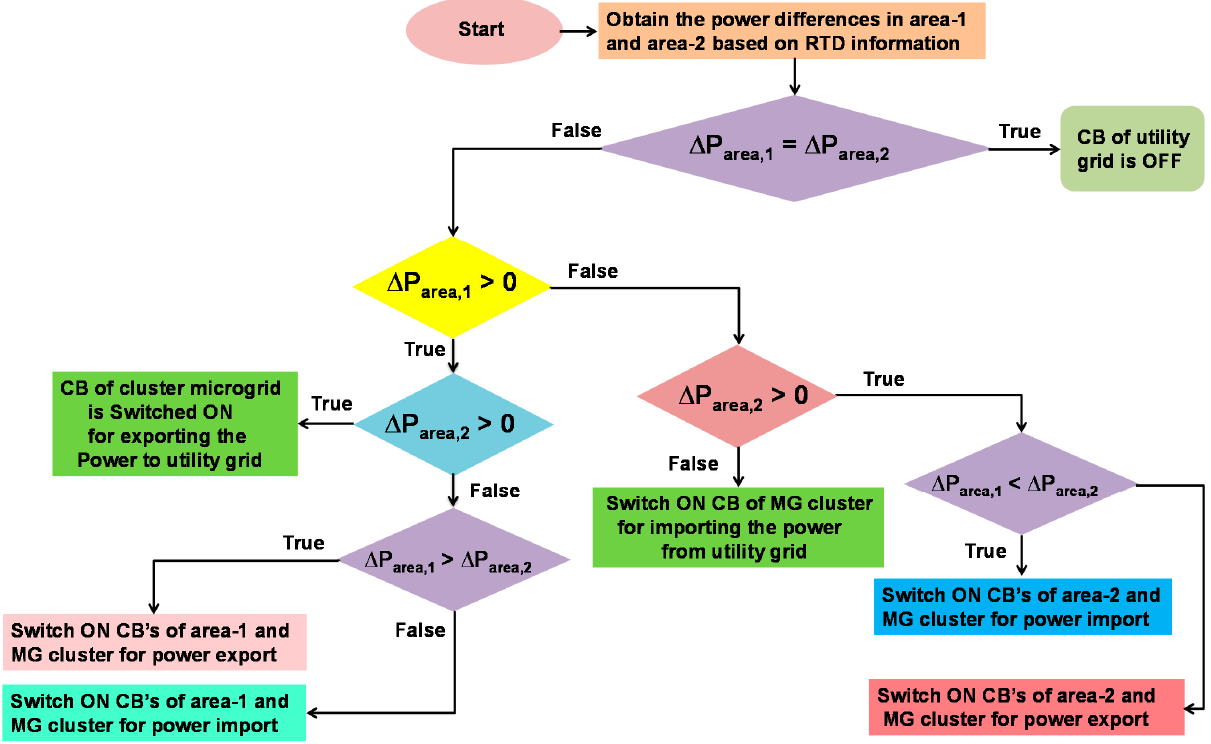
Figure 2. Flowchart of energy management system developed for cluster microgrids.